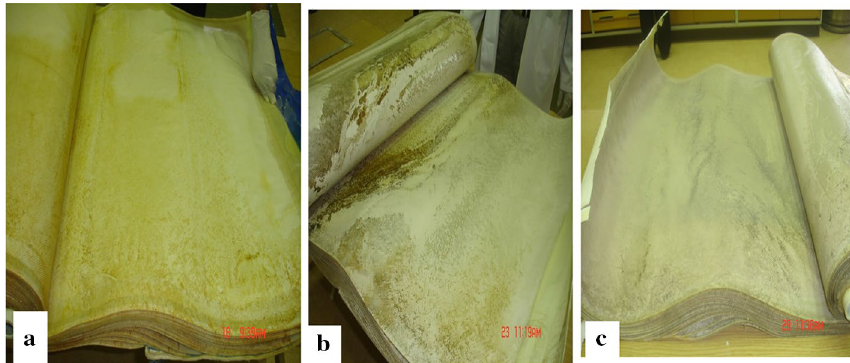
Fig. 5 Autopsied showing